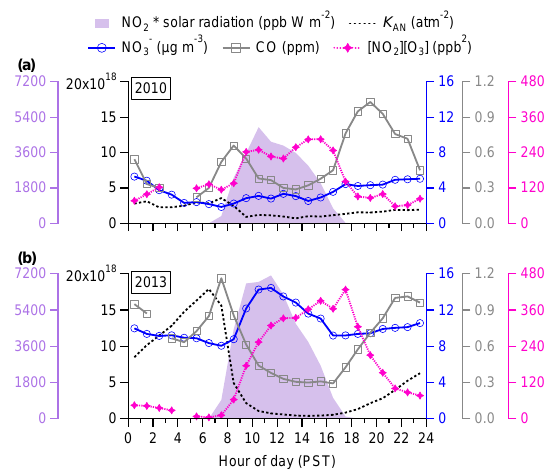
Figure 11. Diurnal profiles for nitrate and various parameters and proxies for formation pathways in 2010 (a) and 2013 (b) . Param- eters shown include temperature, CO for boundary layer dynam- ics, [NO 2 ][O 3 ] as a proxy for nighttime formation of HNO 3 and subsequently particulate nitrate, [NO 2 ] times solar radiation as a proxy for daytime HNO 3 formation and K AN as the equilibrium constant for gas-to-particle partitioning for ammonium nitrate. As ammonium nitrate formation is dependent on temperature and hu- midity, fog events, cold periods, and precipitation events have been removed from the respective data sets prior to the